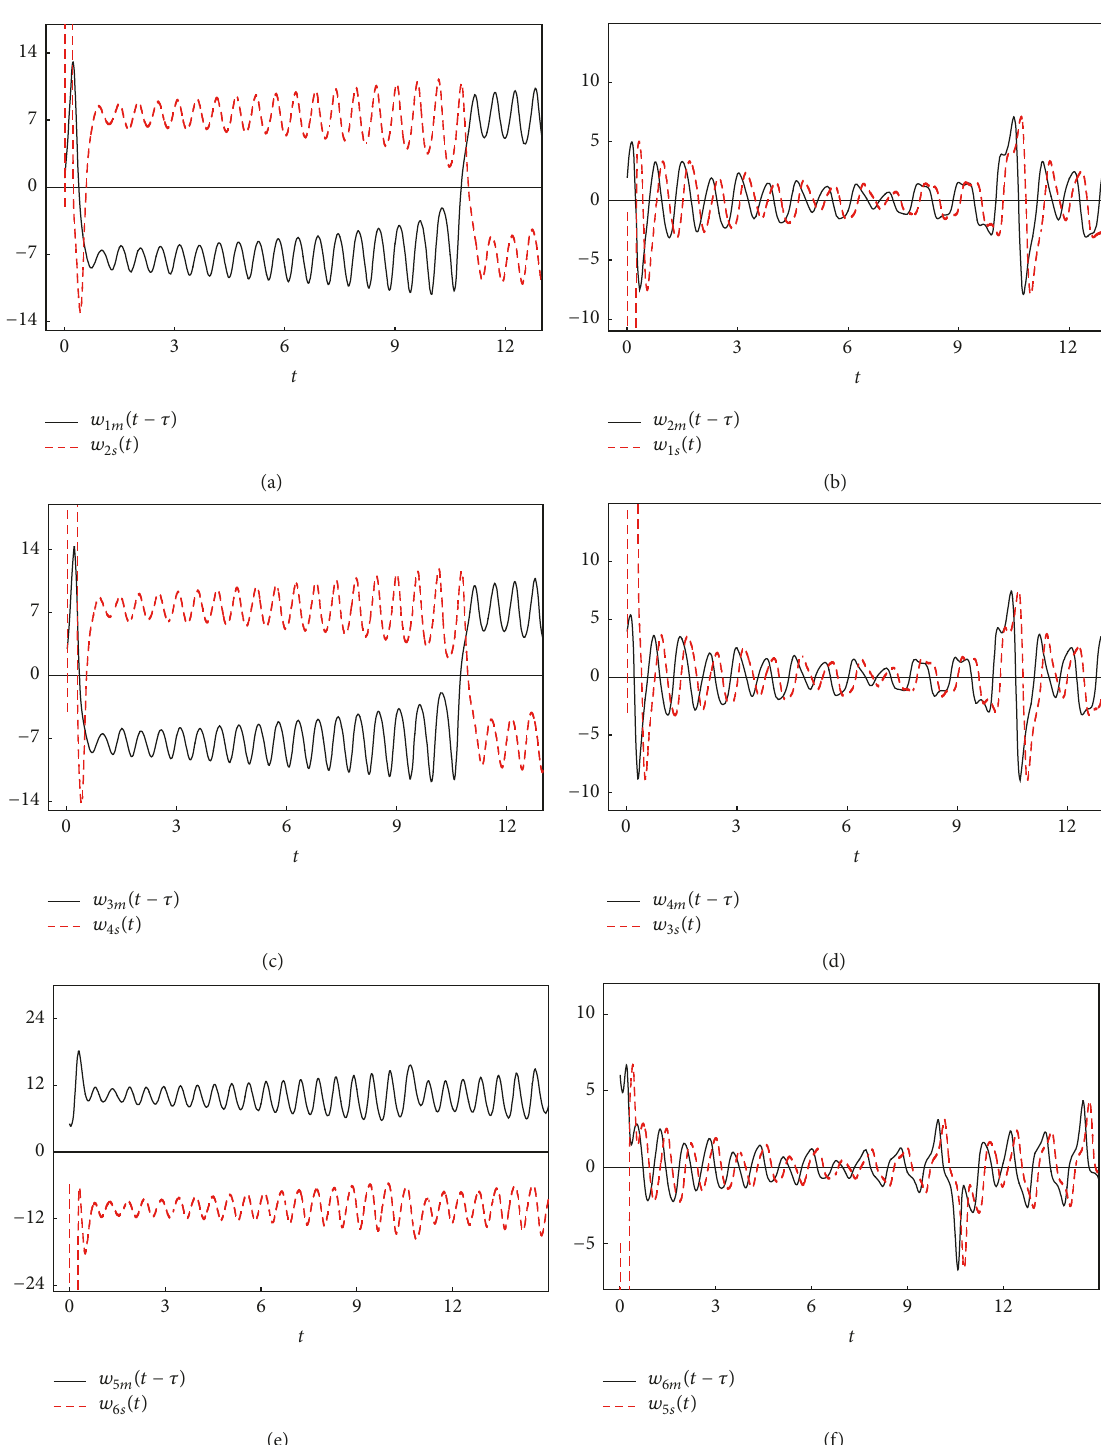
Figure 4: CALS between two identical systems (34) and (35) with the controller (40). (a) 𝑤 1𝑚 (𝑡 − 𝜏) and 𝑤 2𝑠 (𝑡) . (b) 𝑤 2𝑚 (𝑡 − 𝜏) and 𝑤 1𝑠 (𝑡) . (c) 𝑤 (𝑡 − 𝜏) and 𝑤 (𝑡) . (d) 𝑤 (𝑡 − 𝜏) and 𝑤 (𝑡) . (e) 𝑤 (𝑡 − 𝜏) and 𝑤 (𝑡) . (f) 𝑤 (𝑡 − 𝜏) and 𝑤 (𝑡) . 3𝑚 4𝑠 4𝑚 3𝑠 5𝑚 6𝑠 6𝑚 5𝑠